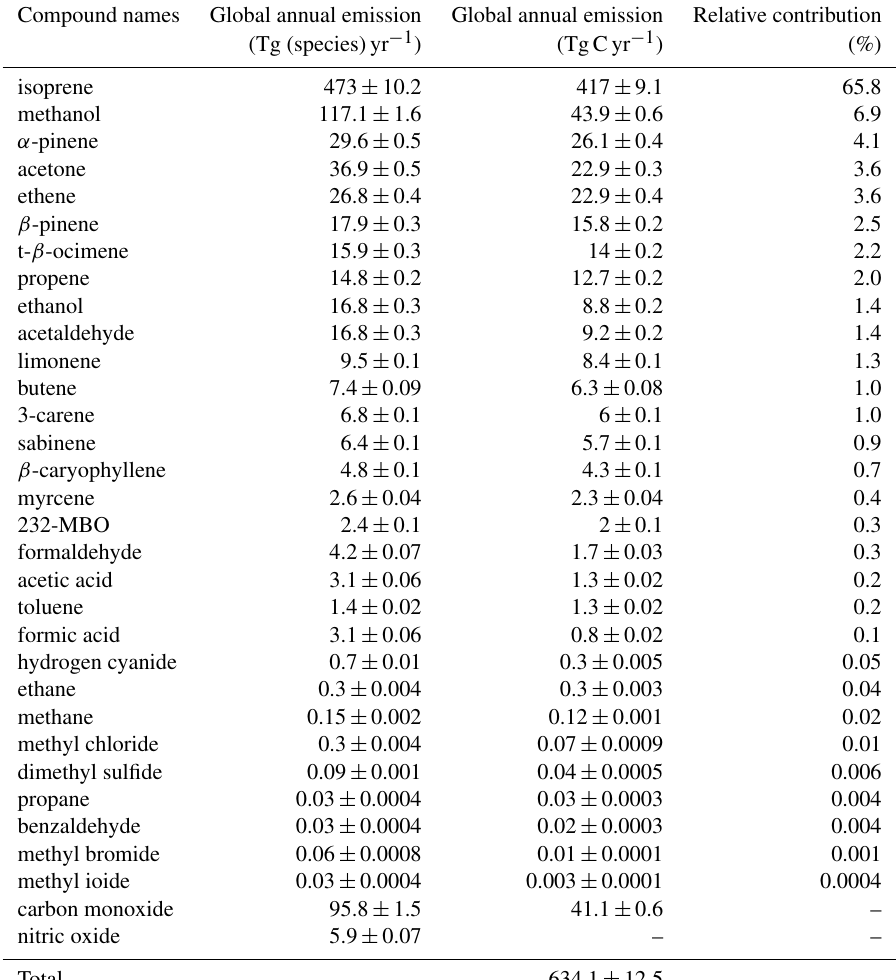
Table 4. Global annual emission totals averaged over the 12 years (2000–2012) of the reference simulation for the 32 compounds and relative contributions to the global annual emission total. Averaged values are given with the standard deviation σ